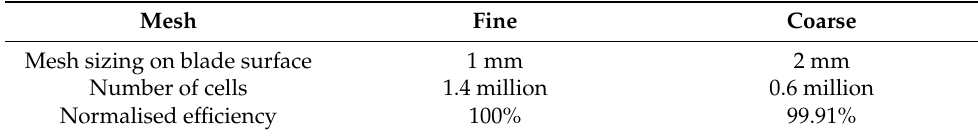
Table 3. Comparison of fine and coarse